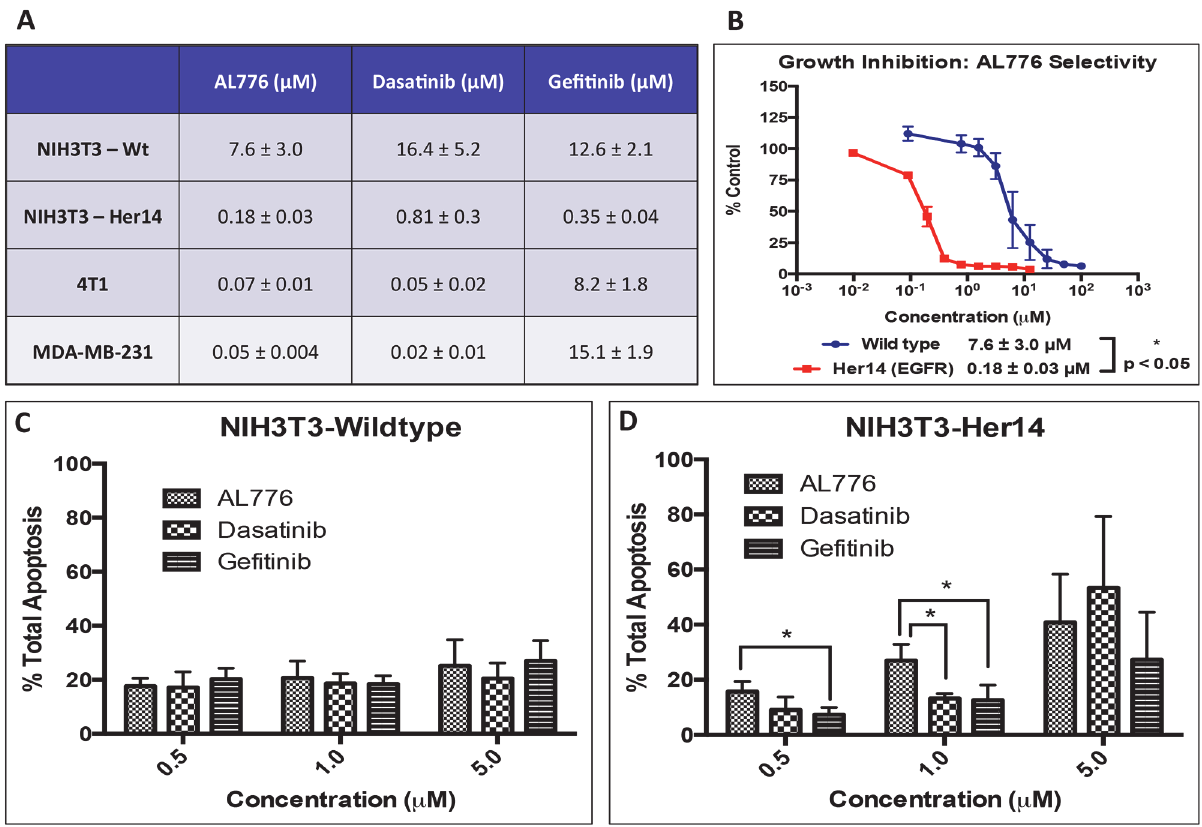
Fig 9. Growth inhibitory and apoptotic properties of AL776. ( A ) Growth inhibition was carried out in NIH3T3 wild type and Her14 (EGFR transfected), 4T1 and MDA-MB-231 cell lines using the sulforhodamine B (SRB) assay. Cells were treated with varying doses of AL776, gefitinib or dasatinib for a period of 5 days following which cells were fixed, stained and quantified. Each experiment was repeated at least four times and carried out in triplicates. ( B ) Comparison of the growth inhibition curves and corresponding IC 50 values of AL776 in the isogenic NIH3T3 wild type and EGFR transfected cell lines. Each point represents the average ± SEM of five independent experiments carried out in triplicates. The difference between their average IC 50 values was statistically significant with p < 0.05. ( C , D ) Annexin V and propidium iodide staining (PI) of cells was used to determine the percentage of apoptosis (early + late) induced by AL776, gefitinib and dasatinib. Cells were treated with different doses of AL776 for 48h, collected, stained and analyzed using flow cytometry. The histogram represents the average ± SEM of three independent experiments with p < 0.05 in the NIH3T3-EGFR transfected cell line.